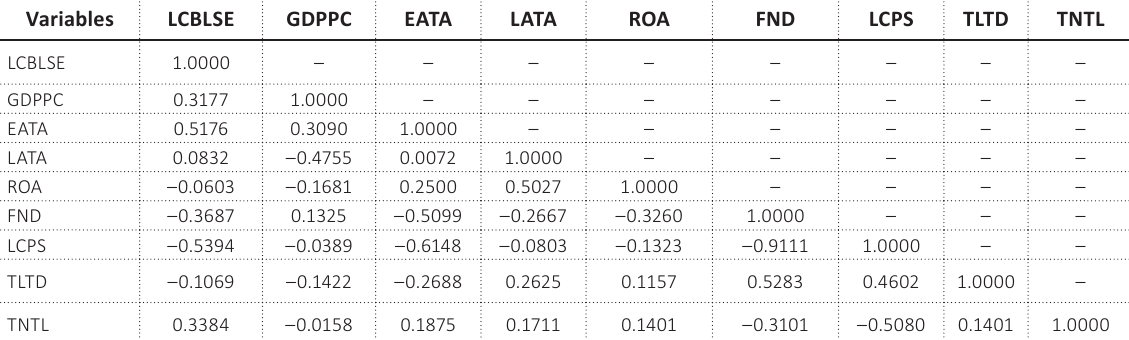
Table 4. ADF unit root tests for the variables at levels and first differences